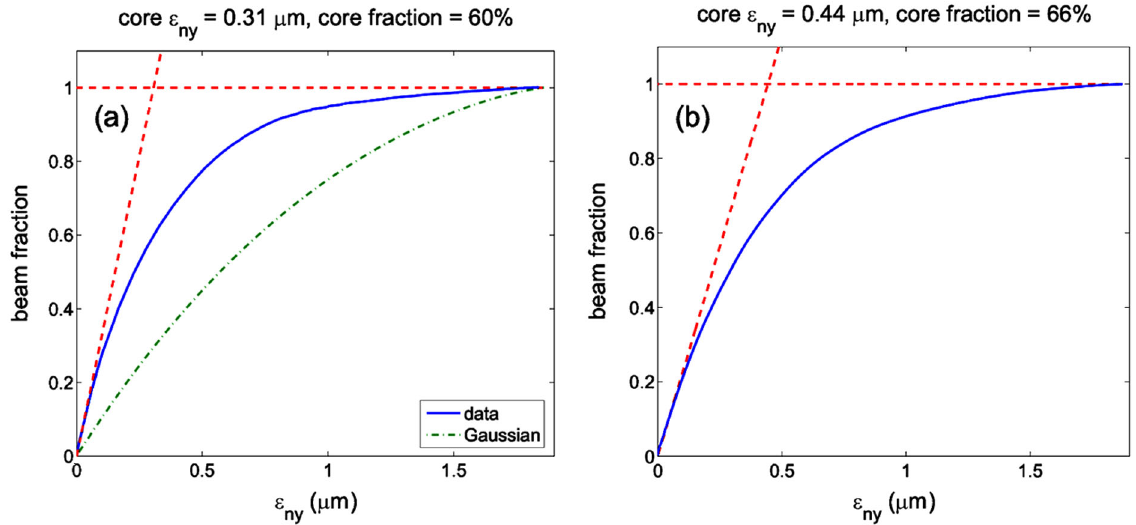
FIG. 21. (Color) Normalized rms emittance vs included beam fraction for measured (a) and calculated by GPT (b) phase space distributions for 80 pC = bunch . A corresponding Gaussian beam is also shown for comparison. The 100% normalized rms emittance is 1 : 8 (cid:2) 0 : 2 (cid:1) m for the measurement (a) and 1 : 8 (cid:1) m for GPT